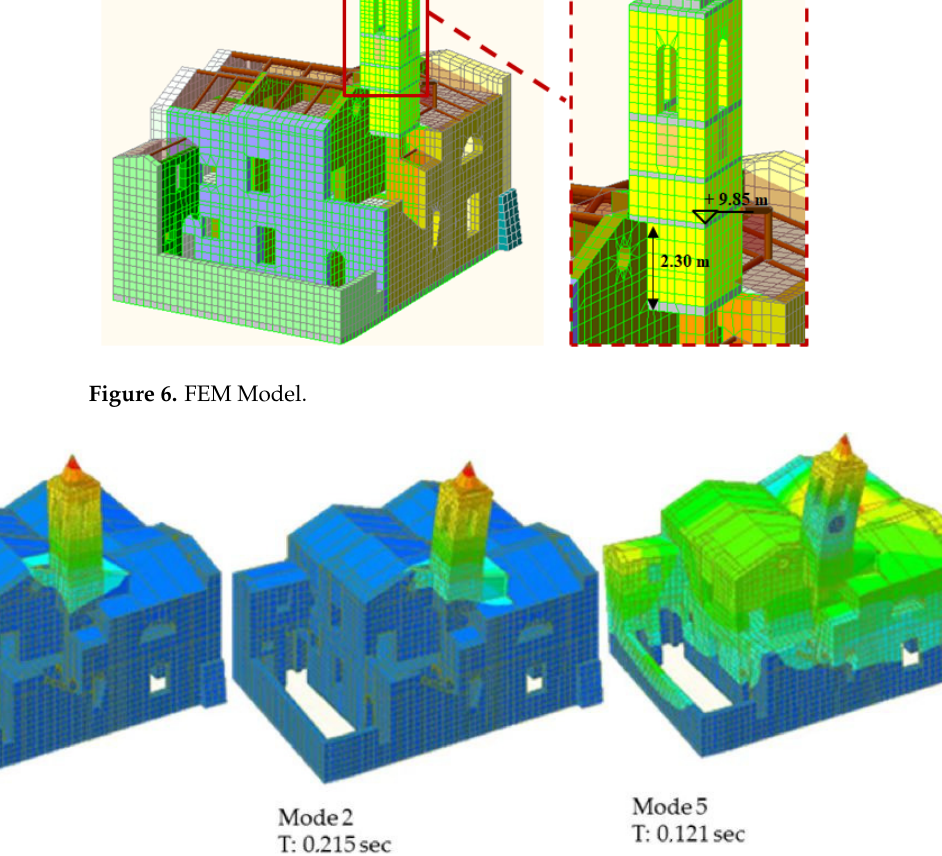
Figure 6. FEM Model. Figure 7. Modal analysis of the building. Mode n. 1, 2 and